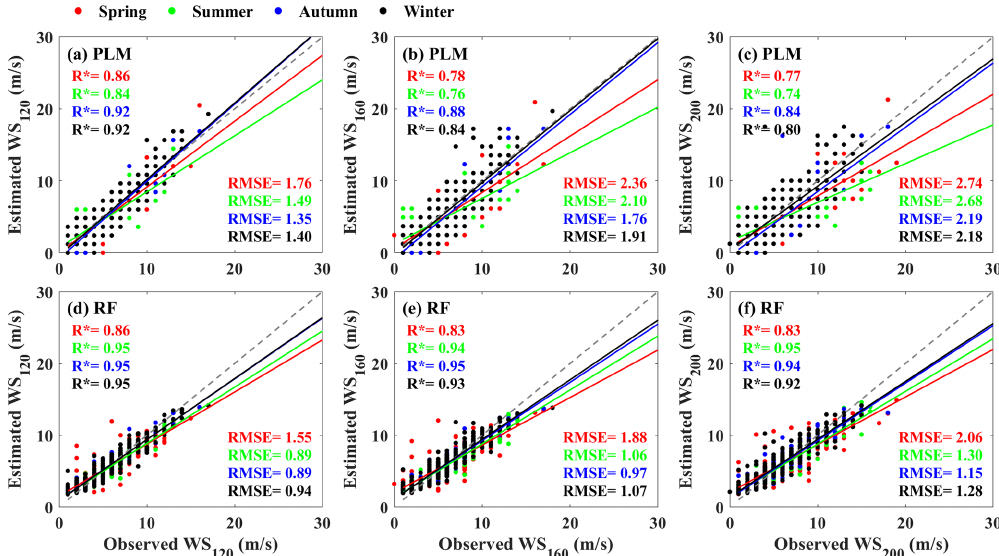
Figure 6. Comparisons between observed wind speed and estimated wind speed for (a, b, c) the PLM and (d, e, f) RF at 120, 160, and 200m in different seasons. The red, green, blue, and black represent spring, summer, autumn, and winter, respectively. The asterisk indicates that the correlation coefficient ( R ) has passed the t test at a confidence level of